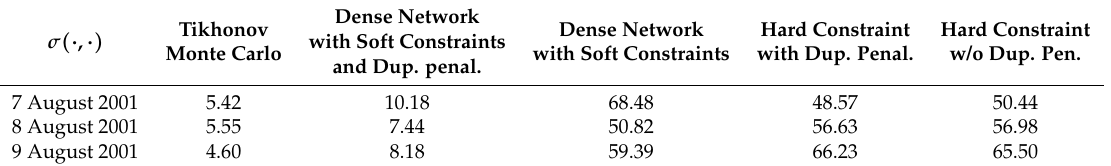
Dense Network with Soft Constraints